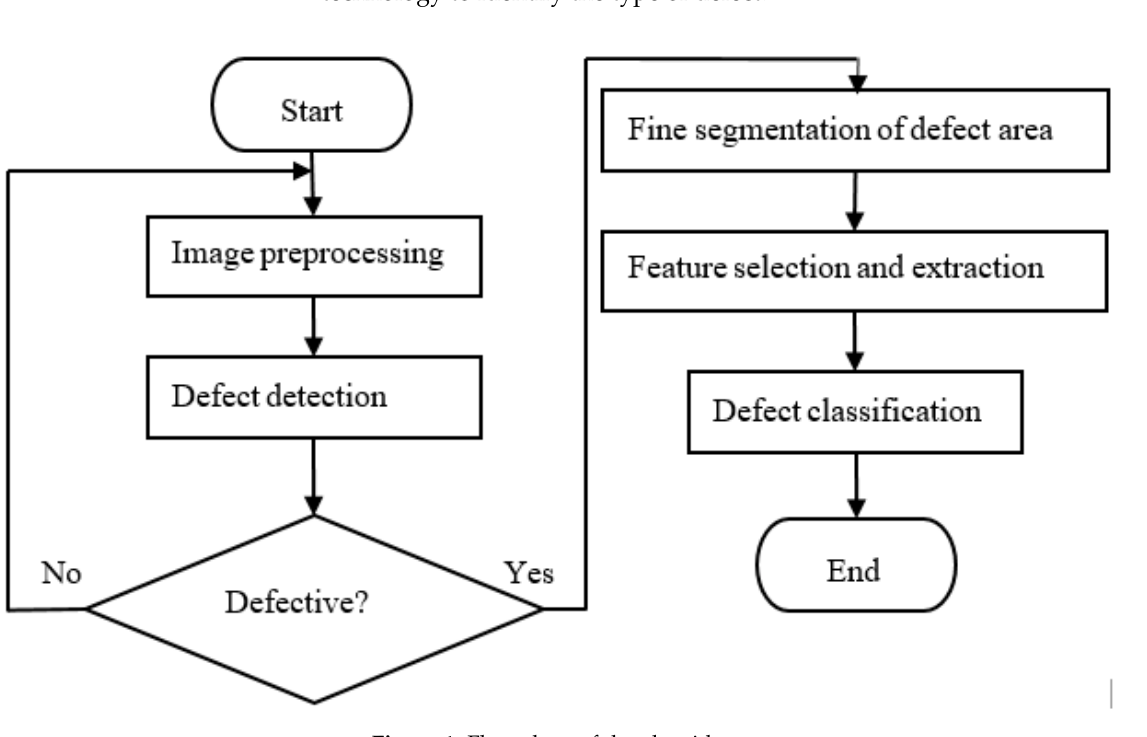
Figure 1. Flow chart of the algorithm.